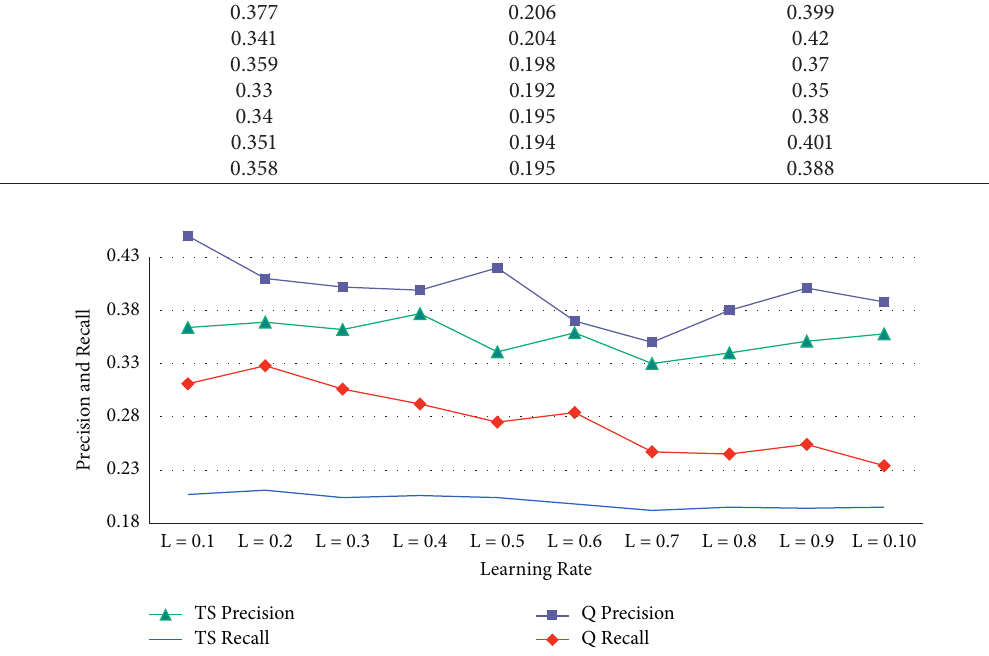
Figure 3: Performance of NN-QuPiD Attack with Multilayer Perceptron Table 4: Performance of NN-QuPiD Attack with RNN algorithm and Topic Score feature vector.